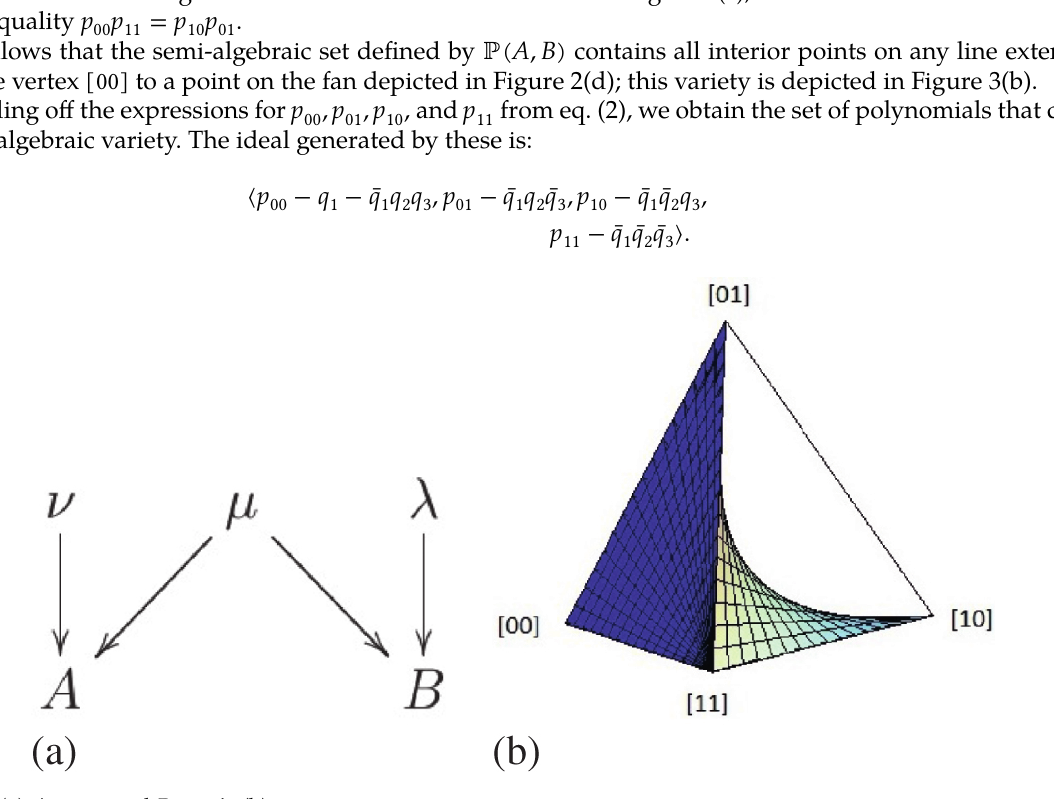
u ≥ u u 00 11 01 10